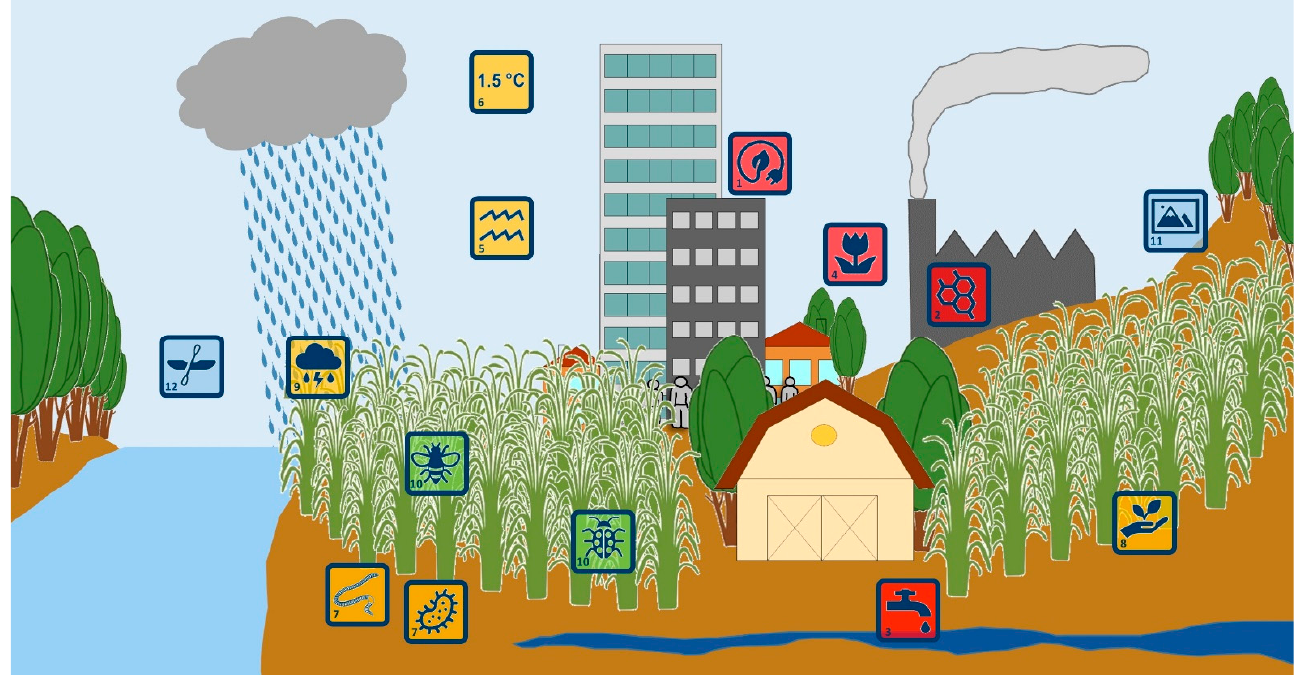
Figure 1. Overview of the main ecosystem services considered in this study in accordance with von Cossel et al. (2020b) [9]. Provisioning ecosystem services (in red): (1) raw material, (2) genetic resources, (3) fresh water/groundwater, (4) ornamental resources; Regulating ecosystem services (in orange): (5) air quality regulation, (6) climate regulation, (7) improvement of soil fertility, (8) erosion prevention, (9) moderation of extreme events; habitat ecosystem services (in green): (10) pollination and biocontrol; cultural ecosystem services (in blue): (11) aesthetic information and (12) recreation and